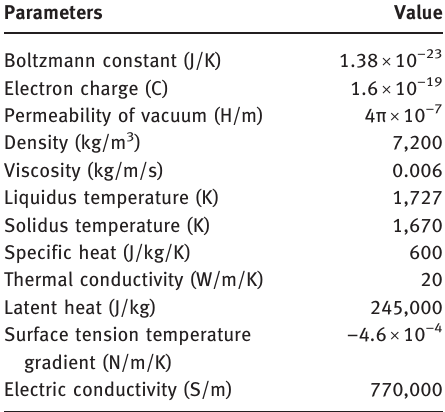
Table 2: Physical parameters and material (SUS304)